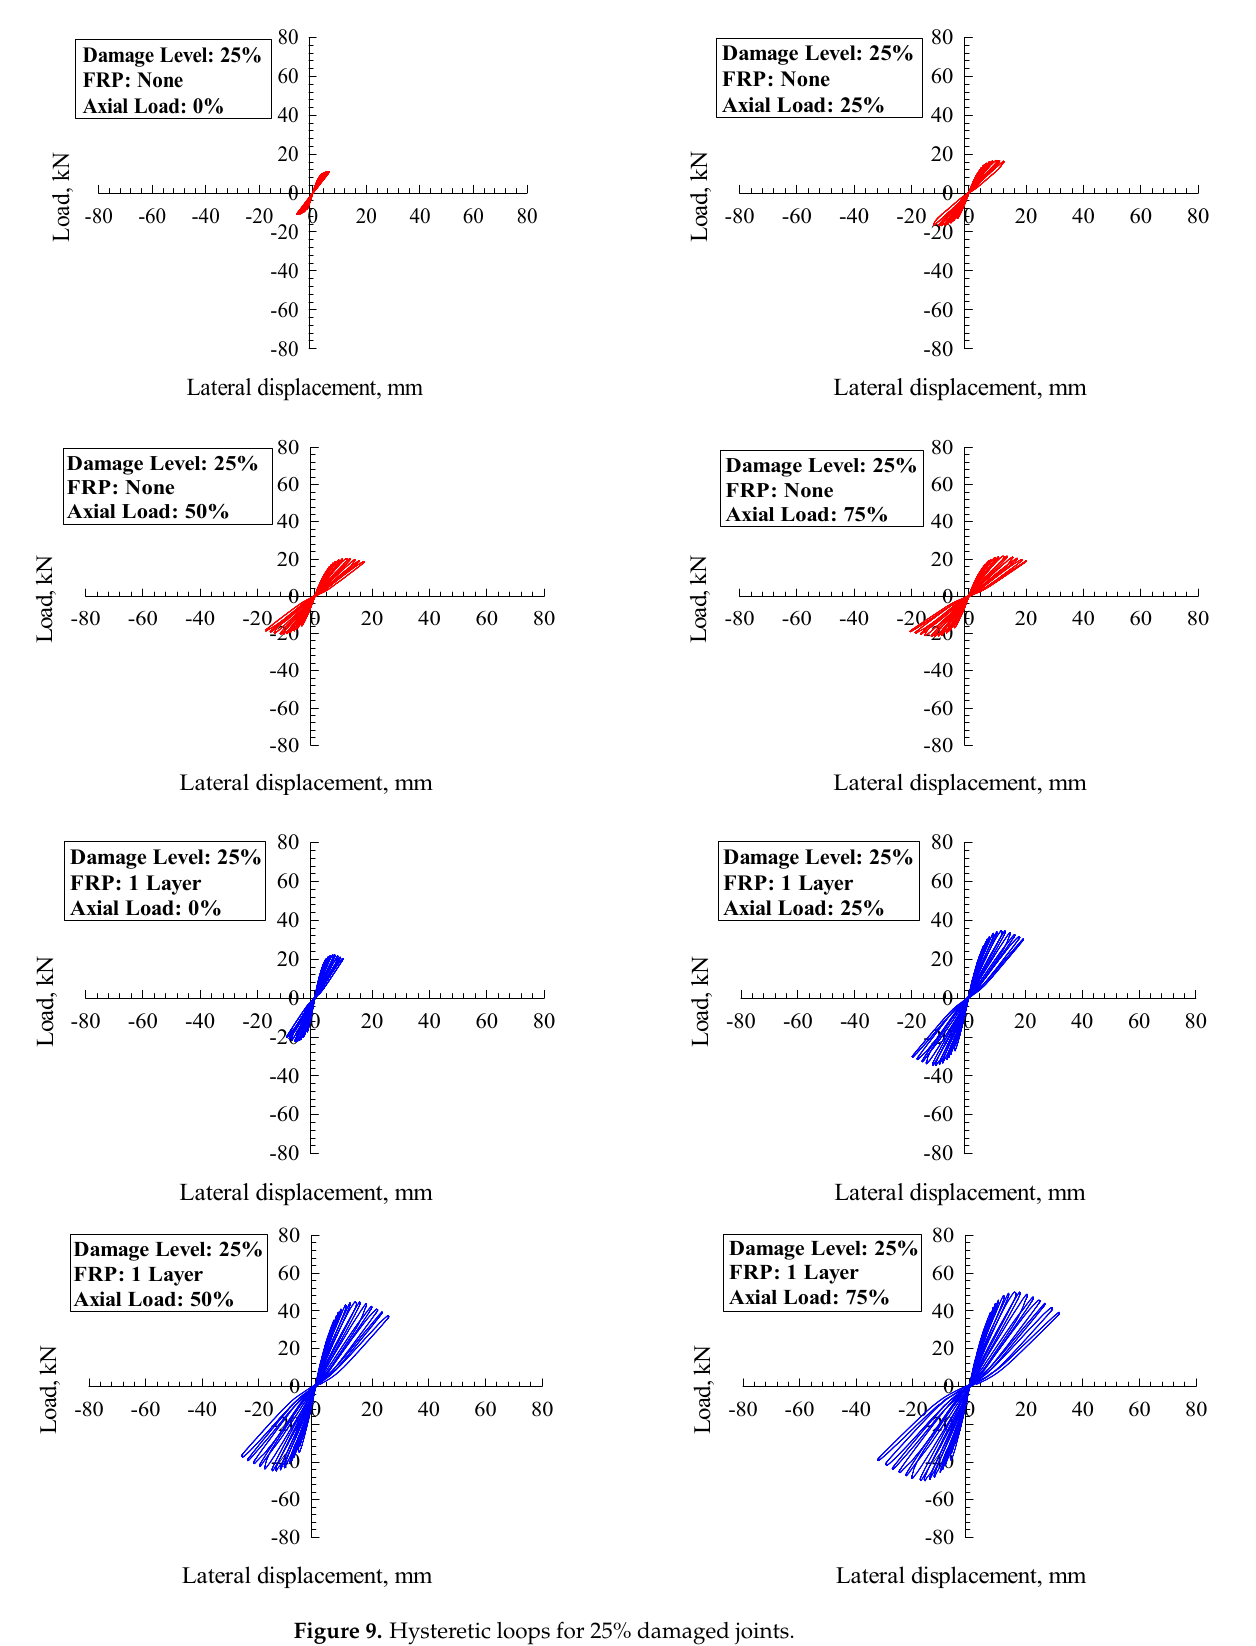
Figure 9. Hysteretic loops for 25% damaged joints.